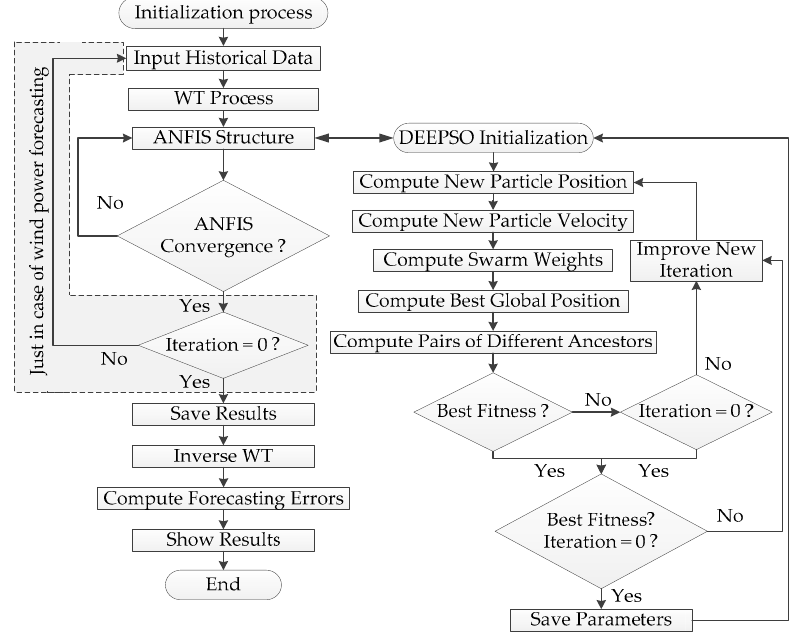
Figure 4. HWDA (hybrid WT+DEEPSO+ANFIS) forecasting approach flowchart. Table 1. DEEPSO (differential evolutionary particle swarm optimization) and ANFIS (adaptive neuro-fuzzy inference system) parameters used for EMP (electricity market price) and wind power forecasting.